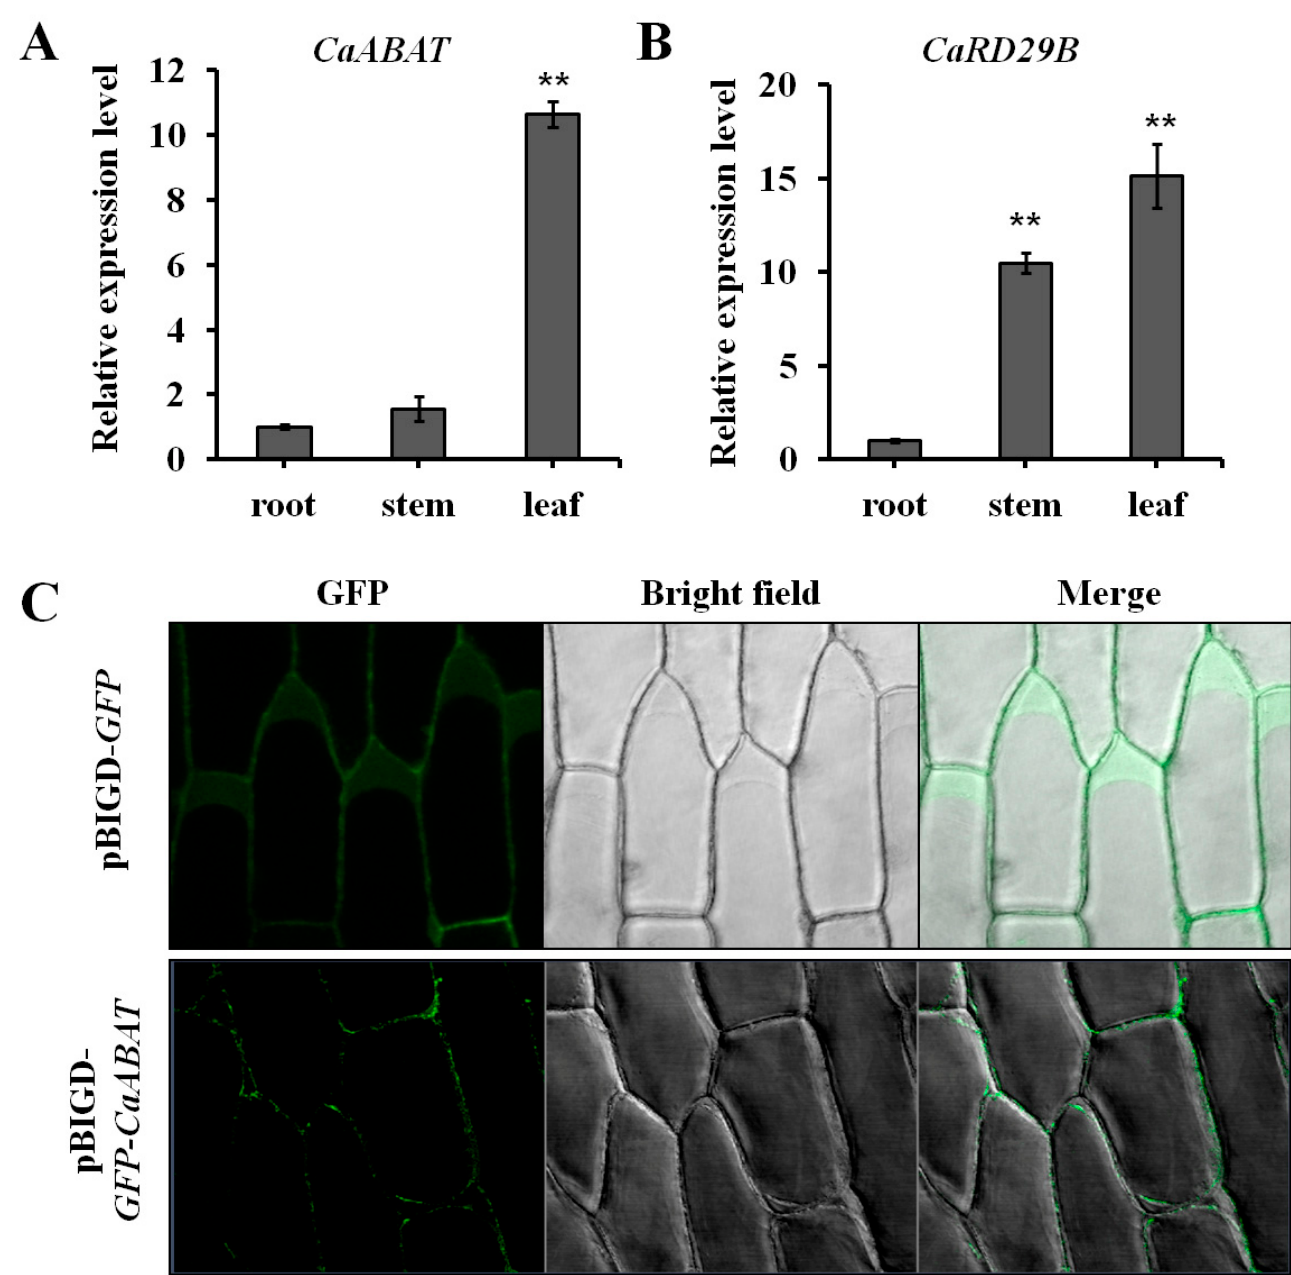
Figure 3. Expression analysis and subcellular localization of CaABAT. ( A ) Tissue-specific expression analysis of CaABAT in C. acuminata. ( B ) Tissue-specific expression analysis of CaRD29B in C. acuminata. ( C ) Subcellular localization of CaABAT in onion epidermal cells. The error bars represent standard deviations from three biological replicates, and asterisks indicate statistically significant differences compared with pDRGAL. ** p < 0.01.